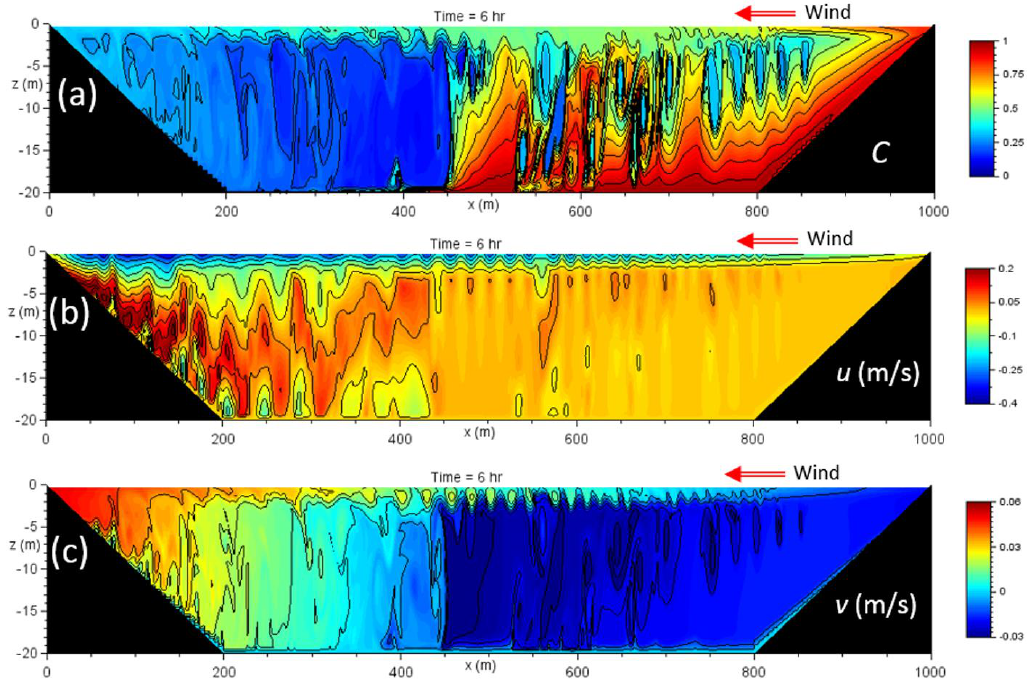
Figure 15. Scenario A ( N = 0) with τ x = −0.1 Pa, simulated with the 2.5-dimensional version of the nonhydrostatic model (see [17]) accounting for rotational effects using a Coriolis parameter of f = 1 × 10 −4 s −1 . Shown are the distributions after 6 h of simulation of ( a ) the concentration field C (compare with Figure 4b); ( b ) offshore velocity u (compare with Figure 5a) and ( c ) alongshore velocity v. Except for the creation of a weak alongshore flow near the downwind boundary, rotational effects have little influence on the dynamics on this timescale.